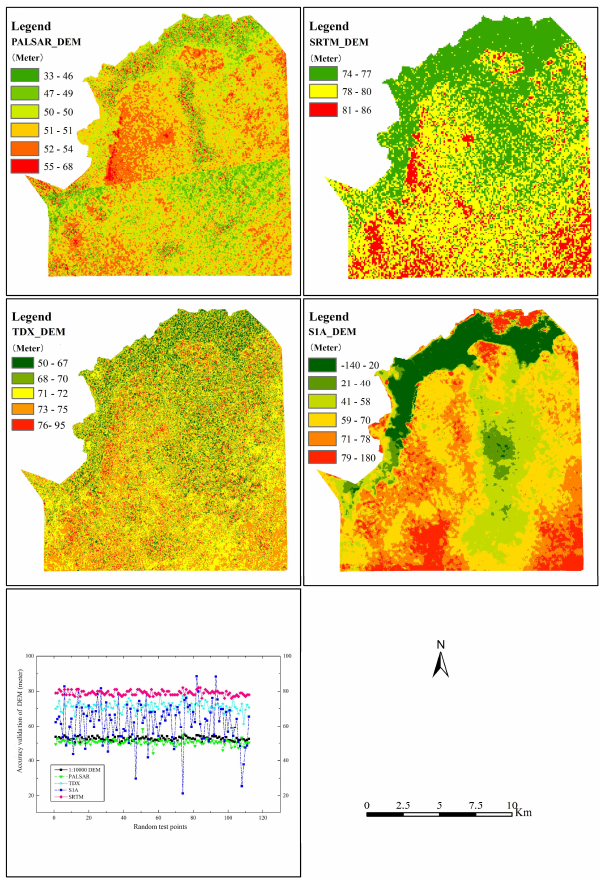
Figure 4 the unwrapping phase after orbital refining and re-flattening ： A was the RGB image derived from wavelet fusion of GF-1 multispectral image and HH polarization Radarsat-2 backscattering intensity data. B was the unwrapping phase using TerraSAR images; C was the unwrapping phase using Sentinel-1A images; D was the unwrapping phase using PALSAR images.